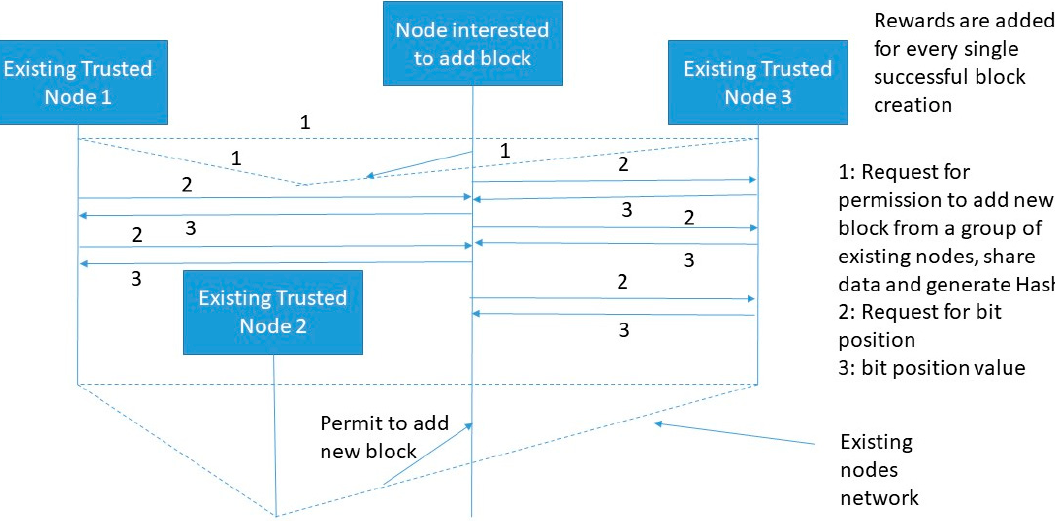
Figure 7. Proposed multi-player single-bit (MPSB) PoG consensus algorithm.